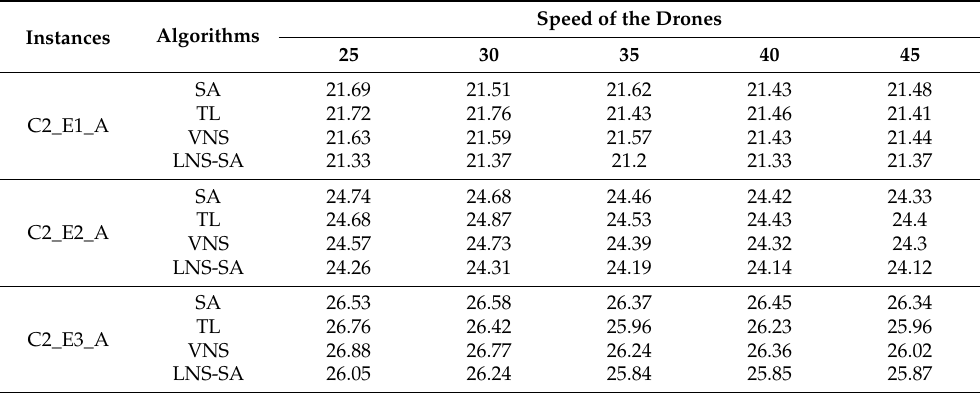
Table 7. Experimental results with different drone